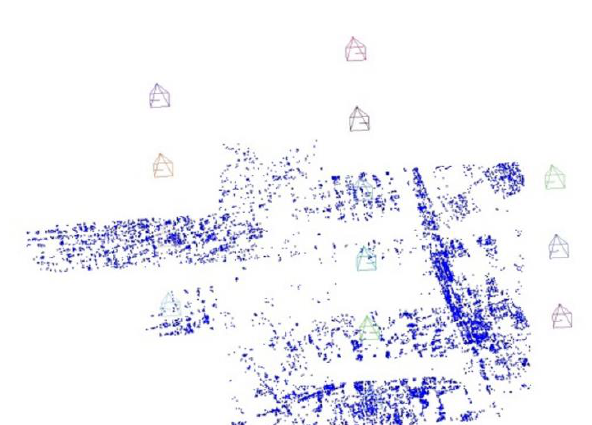
Figure 3. The reconstructed 3D features (blue points) and the camera centres (triangular